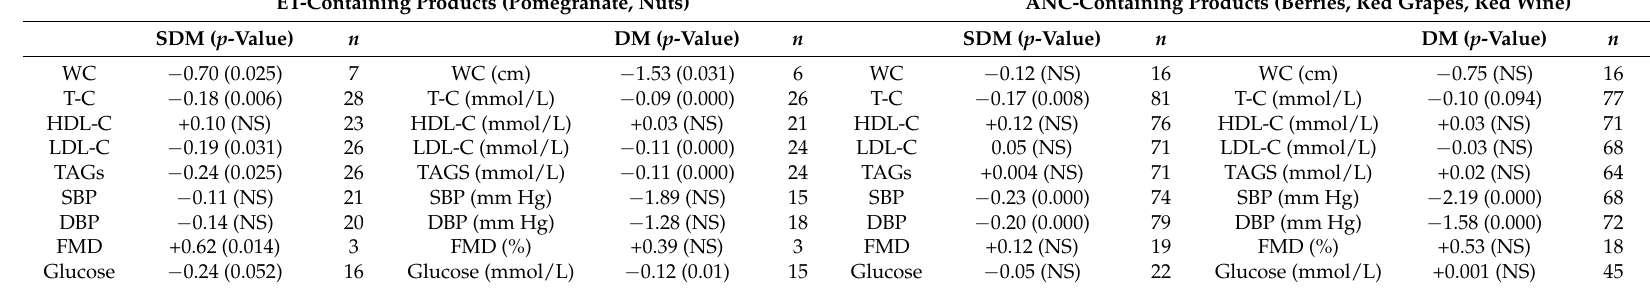
Table 2. Summary of the most significant effects of the foods and food products containing ETs (pomegranate and nuts) and those containing ANCs (berries, red grapes and red wine) on biomarkers of cardiometabolic